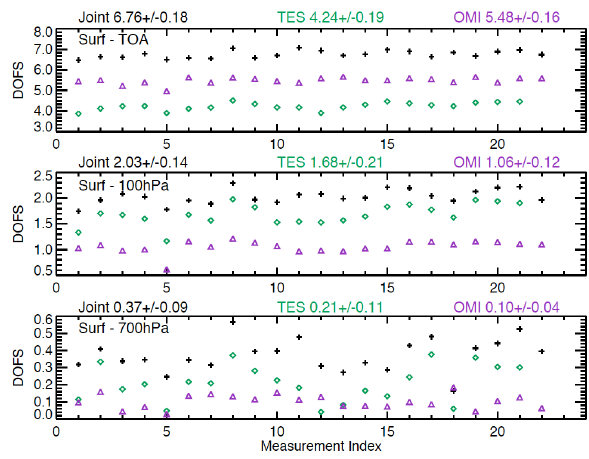
Figure 7 . DOFS for the set of ozone measurements in Table 2: (Top panel) total DOFS; 2 Fig. 7. DOFS for the set of ozone measurements in Table 2: (top (Middle panel) DOFS for the region between the surface and 100 hPa; (Bottom panel) DOFS 3 panel) total DOFS; (middle panel) DOFS for the region between for the region between surface to 700 hPa; Joint OMI and TES (black plus); TES (green 4 the surface and 100hPa; (bottom panel) DOFS for the region be- diamond); OMI (purple triangle). Each scene listed in Table 2 is identified by the 5 tween surface to 700hPa; Joint OMI and TES (black pluses); TES measurement index in the X axis. For Joint TES/OMI measurements, TES alone and OMI 6 (green diamonds); OMI (purple triangles). Each scene listed in Ta- alone, the mean DOFS in the altitude of surface to 700 hPa is 0.37, 0.21, 0.10 respectively; in 7 ble 2 is identified by the measurement index in the x-axis. For the altitude of surface to 100 hPa is 2.03, 1.68, 1.06 respectively; in the altitude of surface to 8 Joint TES/OMI measurements, TES alone and OMI alone, the mean 0.1 hPa is 6.76, 4.24, 5.48 respectively; the 1 # standard deviation of the mean DOFS in the 9 DOFS in the altitude of surface to 700hPa is 0.37, 0.21, 0.10, re- altitude of surface to 700 hPa is 0.09, 0.11, 0.04 respectively; in the altitude of surface to 100 10 spectively; in the altitude of surface to 100hPa is 2.03, 1.68, 1.06, hPa is 0.14, 0.21, 0.12 respectively; in the altitude of surface to 0.1 hPa are 0.18, 0.19, 0.16 11 respectively; in the altitude of surface to 0.1hPa is 6.76, 4.24, 5.48, respectively. 12 respectively; the 1 σ standard deviation of the mean DOFS in the altitude of surface to 700hPa is 0.09, 0.11, 0.04, respectively; in the altitude of surface to 100 hPa is 0.14, 0.21, 0.12, respectively; and in the altitude of surface to 0.1hPa are 0.18, 0.19, 0.16,